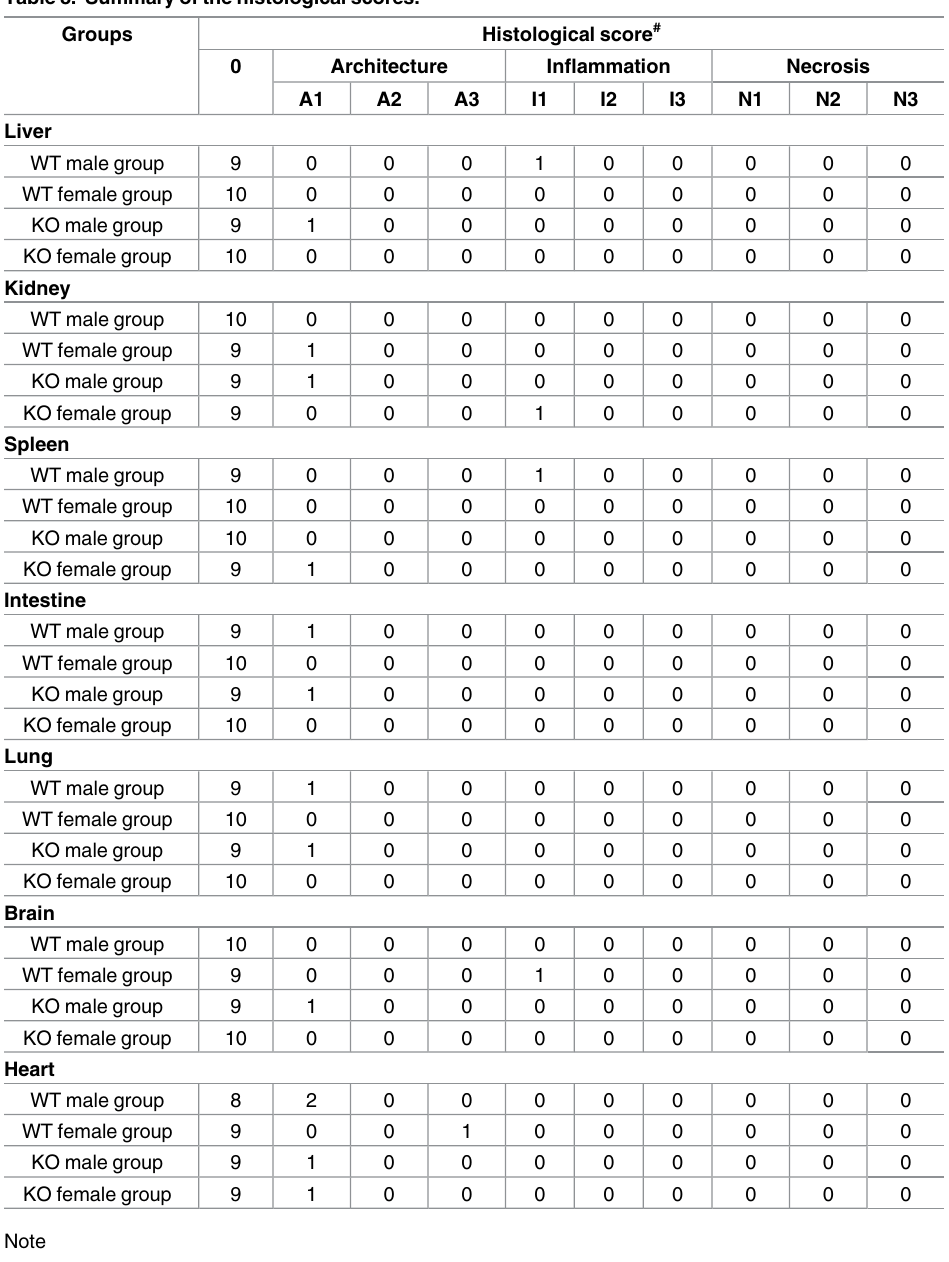
# The numeral in each row indicates the number of mice with a particular